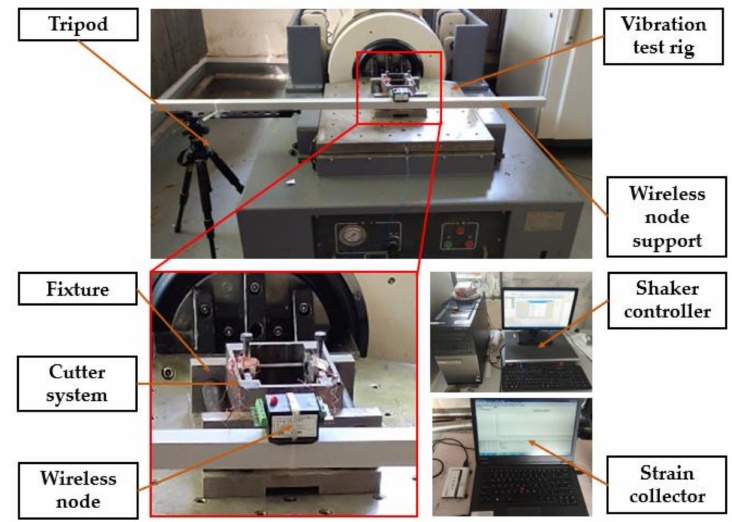
Figure 13. Pictures of the anti-loosening performance test system of the cutter system.